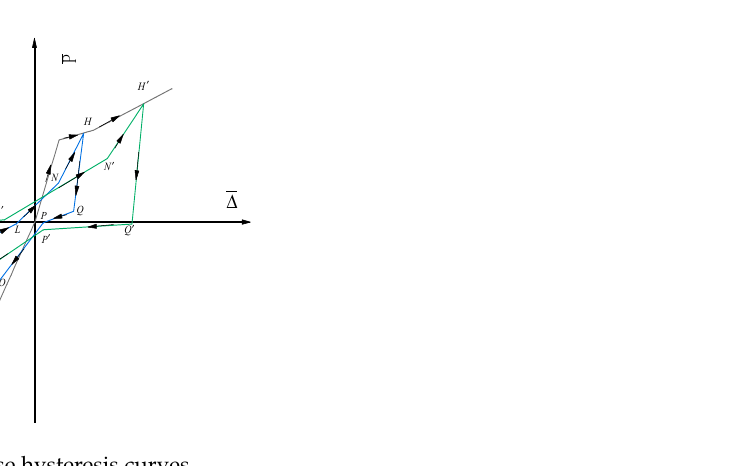
( f ) Figure 18. Fitting curves of the piecewise points: ( a ) Point O; ( b ) Point P; ( c ) Point Q; ( d ) Point M; ( e ) Point L; ( f ) Point N. 4.3. Hysteretic Rule The hysteretic model plays a crucial role in the nonlinear seismic response analysis of structures. The seismic response analysis results may be diverse when different hyster- etic models are adopted. Different kinds of hysteretic model have been widely used to simulate the hysteretic behaviours of different structures. However, it was found that these models cannot simulate the strength degradation and the pinch phenomenon of the hysteretic loops of the Kanchuang frame. A new hysteretic model was proposed to simu- late the hysteretic loops of the Kanchuang frame (see Figure 19). The hysteresis rule is as follows. The loading path follows the envelope curves to point H first. Then, unloading along the paths H–Q with stiffnesses of